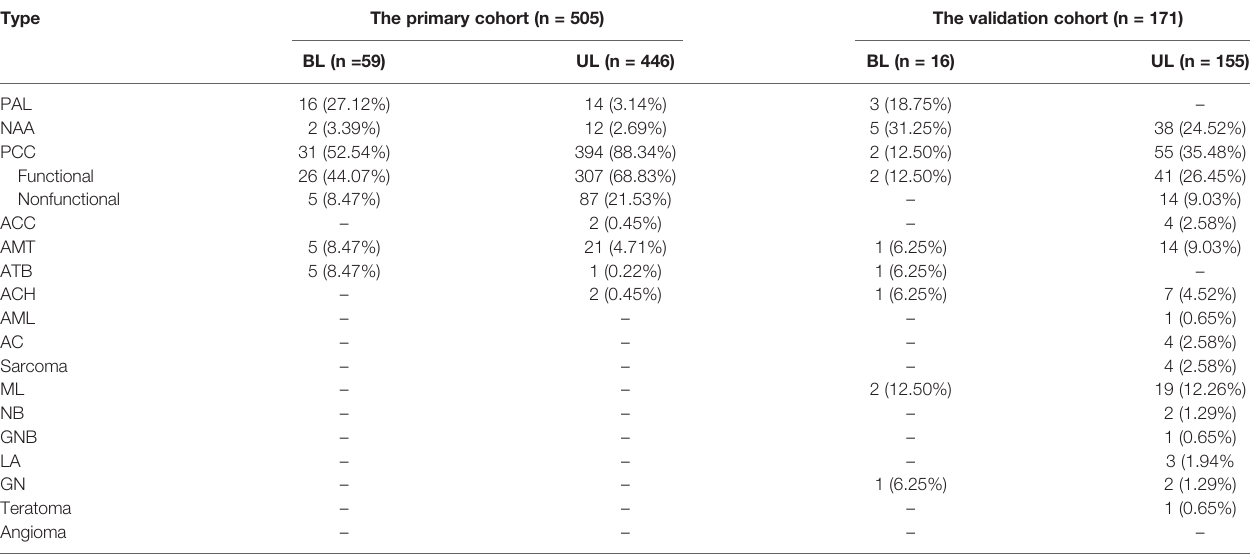
TABLE 1 | The etiology distribution of patients in the primary and validation cohorts.